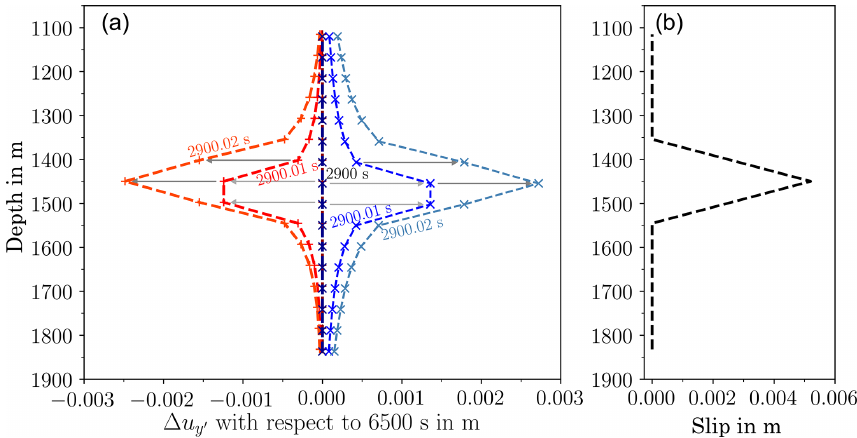
Figure 5. After rotating the displacement vector into the direction of the fault: displacement (cid:49)u y (cid:48) in the y (cid:48) -direction on the fault com- pared with the displacement prior to fault reactivation (a) . For failed elements, the slip (b) is calculated from the difference between the displacement on the right and on the left side (grey arrows).